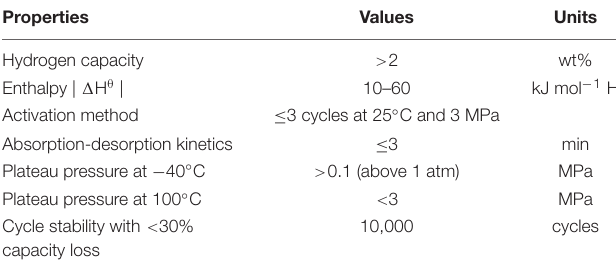
TABLE 2 | Estimated targets for stationary applications.